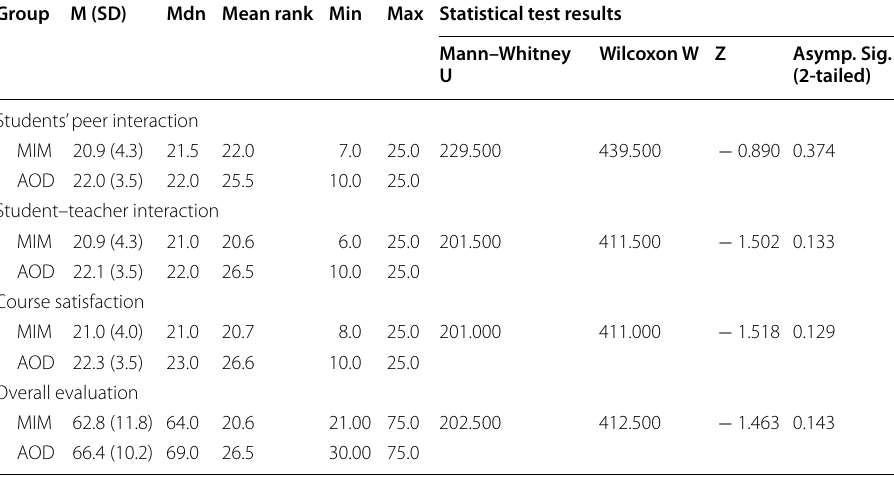
Table 5 Survey results of course interaction and satisfaction and comparison between two groups Group M